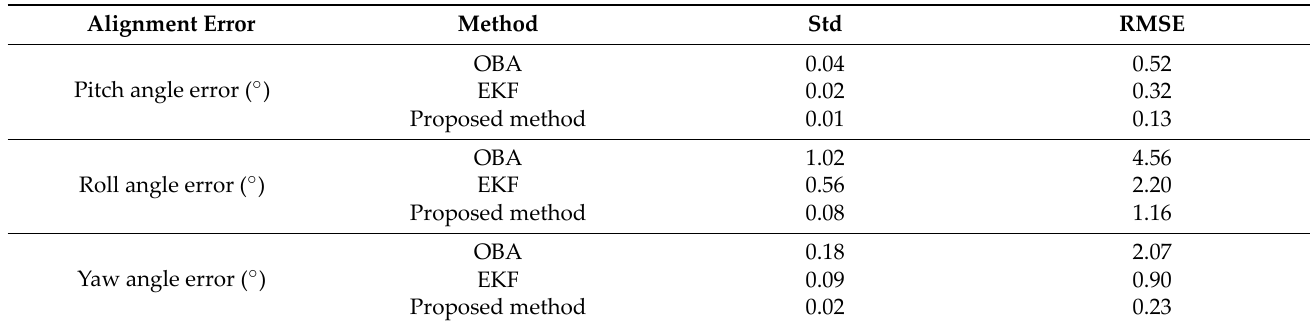
Table 2. Std and RMSE of alignment attitude errors of different IFA methods after convergence in the experiment.